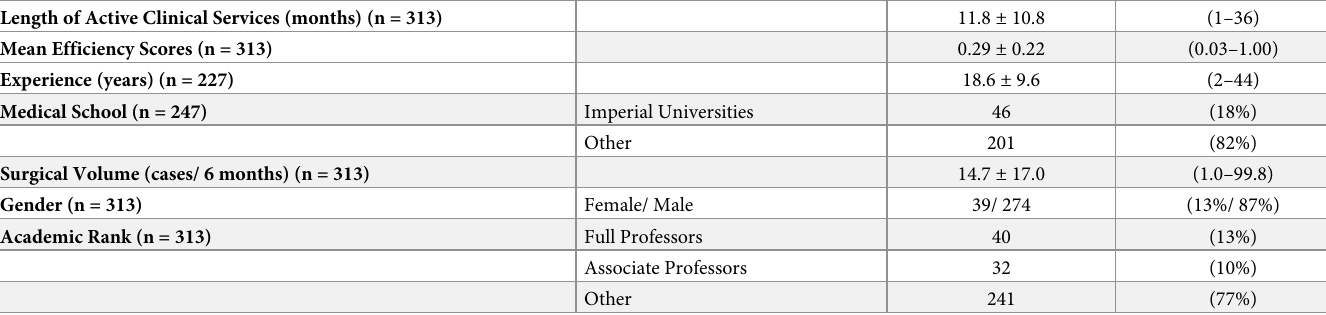
Data are presented as mean ± SD (range) or absolute values (%).